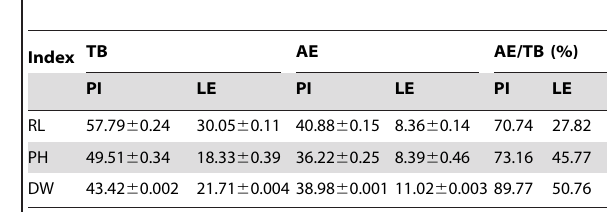
Table 3. Inhibitory rate (%) of barnyardgrass in monoculture and rice/BYG